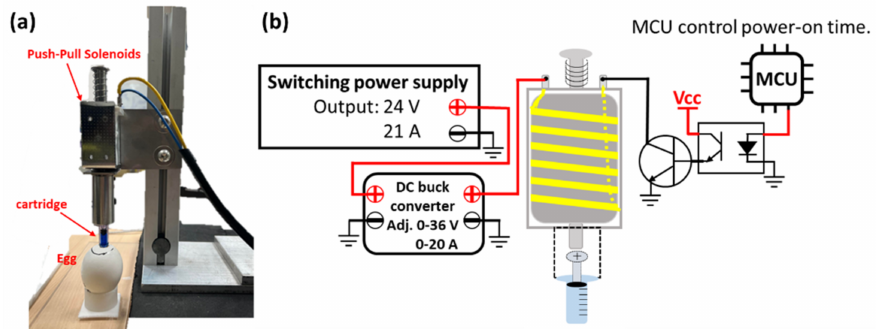
Figure 1. The injection device ( a ) Electromagnetic needle-free in ovo injection device ( b ) Circuit diagram of the electromagnetic needle-free in ovo injection